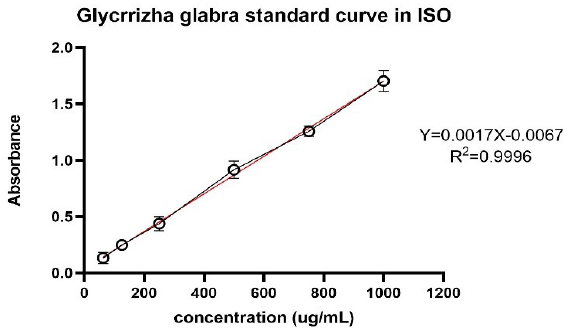
Figure 2. Standard Curve of the Licorice Extract in the Isopropyl Buffer.